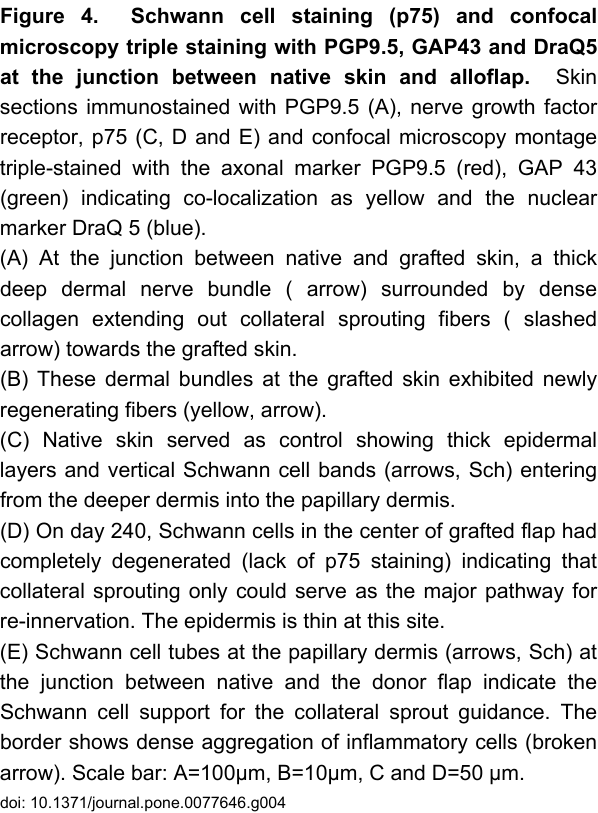
of axonal sprouting in pigs (60 μm/day), however, was relatively faster when compared to our clinical trials with